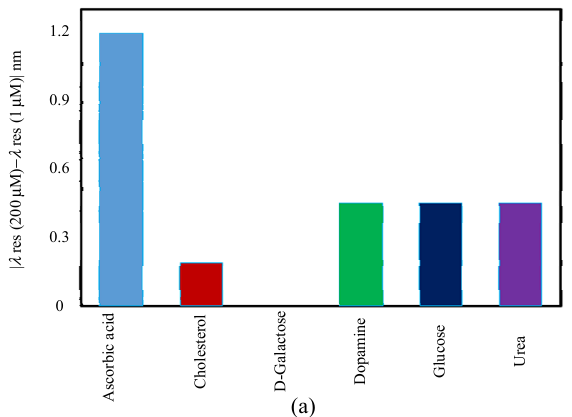
Fig. 18 Selectivity test: (a) Probe I and (b) Probe II.